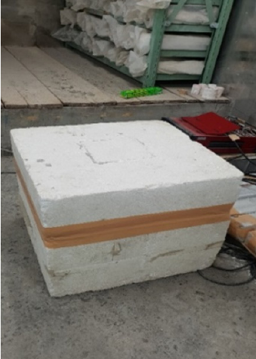
Figure 3. Concrete during casting for temperature rise in concrete measurement in the semi adiabatic condition.